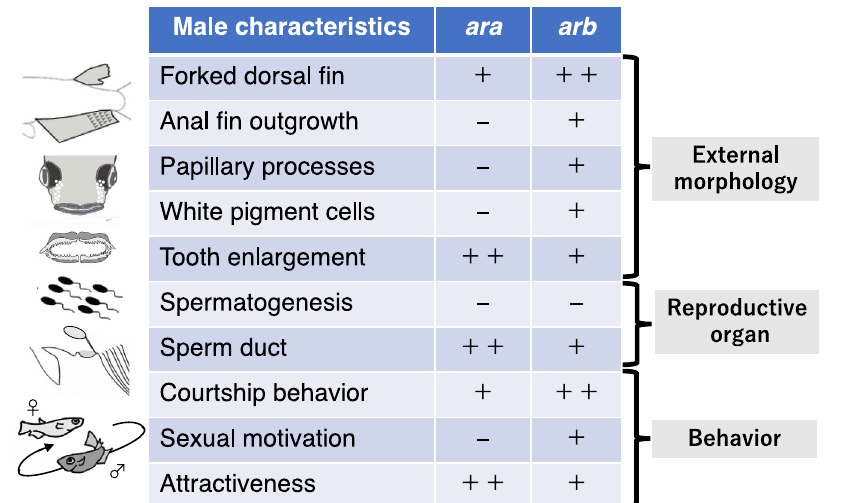
Fig. 7 | Summary of the contribution of ara and arb to sexual